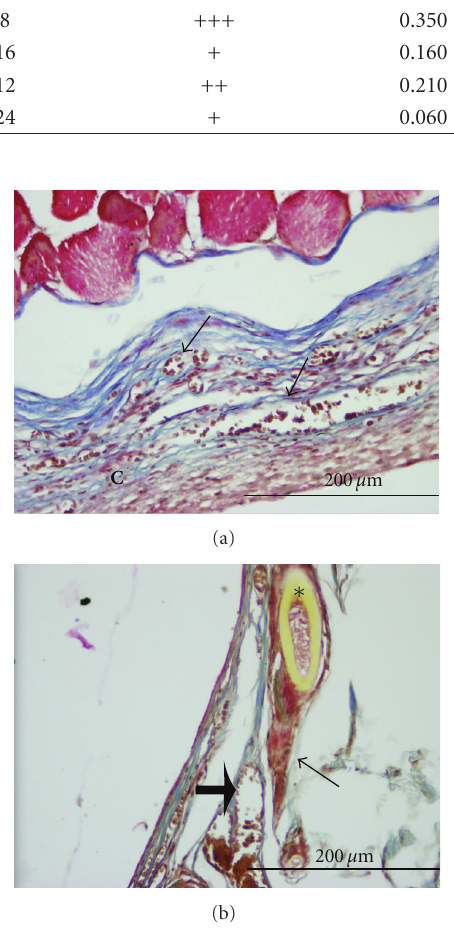
Figure 3: 30th day of implantation of Au-PP-PEG-2000 (a) and Au-PP-PEG-4000 (b). (Mason’s Trichrome staining, 40x magnifi- cation.) The capsule is thicker with more inflammatory cells and newly formed blood vessels (thin arrow) in Au-PP-PEG-2000 (a), and neovascularization (thick arrow) and giant cell accumulation (thin arrow) is more prominent in histological section of Au-PP- PEG-4000